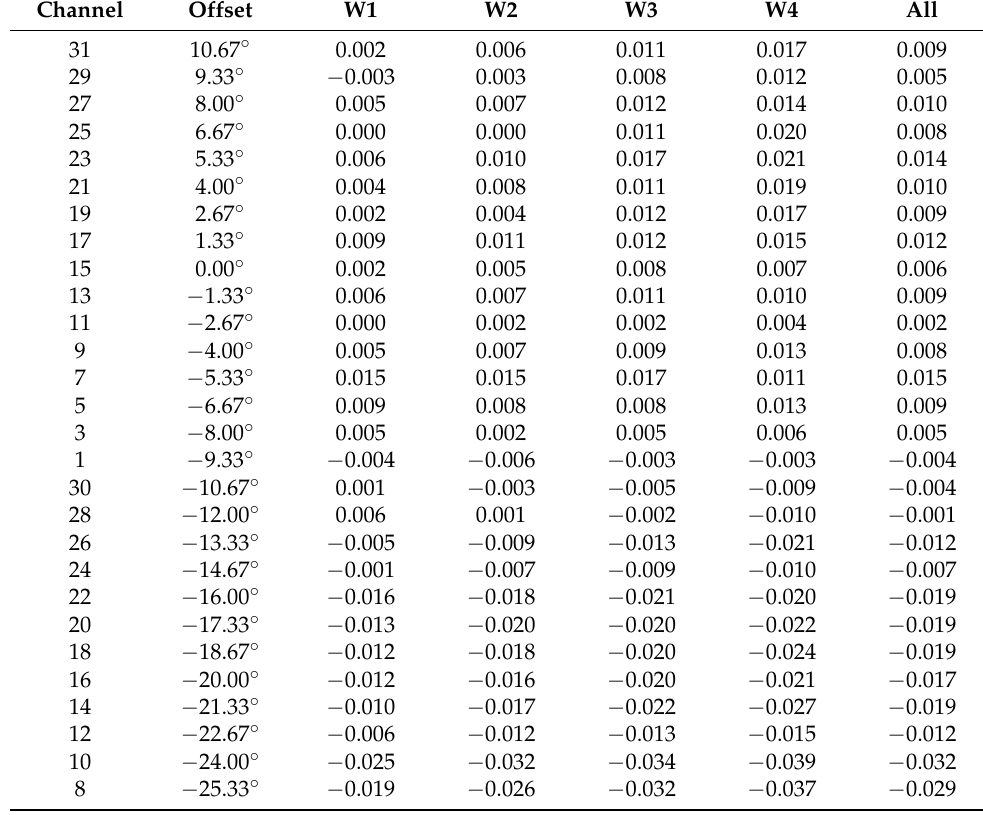
Table A1. Calculated error (m) per individual channel, per subsections of target surface in Velodyne ® HDL–32E during 30 m, night experiment. Subsections are labeled W1 through W4, with W1 being the lowest observed and W4 being the